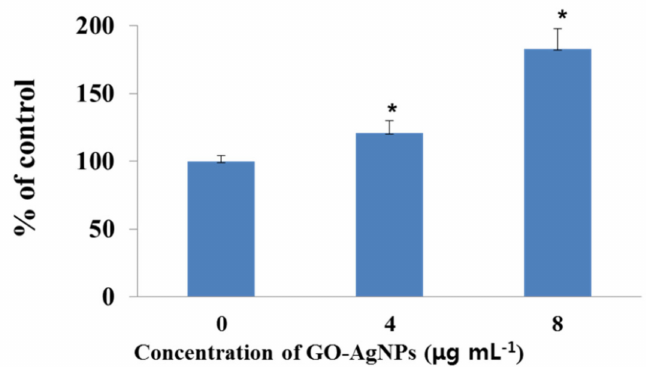
Figure 8. Measurement of lactate dehydrogenase (LDH) activity in GO-AgNP-treated cells. Caprine fetal fibroblast cells (CFFCs) were treated with 0, 4, and 8 µ g/mL of GO-AgNPs for 24 h. The percentage of LDH activity relative to the control group (0 µ g/mL) was determined. Values are presented as the mean ± SD of five independent experiments (* p < 0.05).